Question: According to this chart, does the measure grow or shrink?
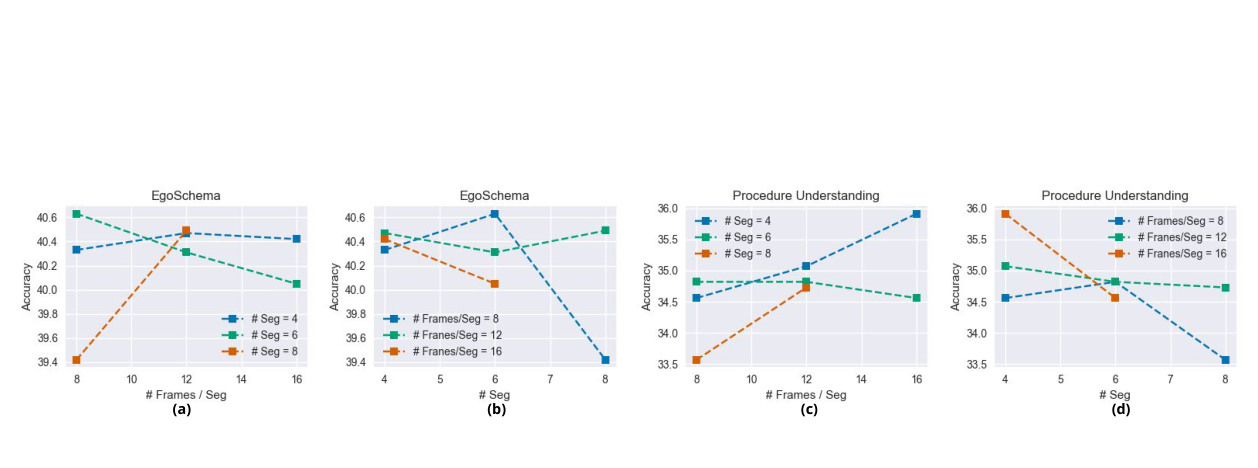
Answer: increasing